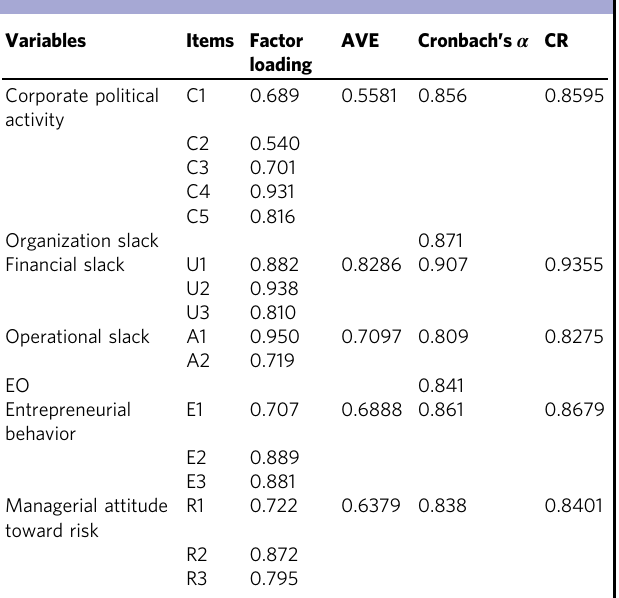
Table 2 Descriptive statistics.